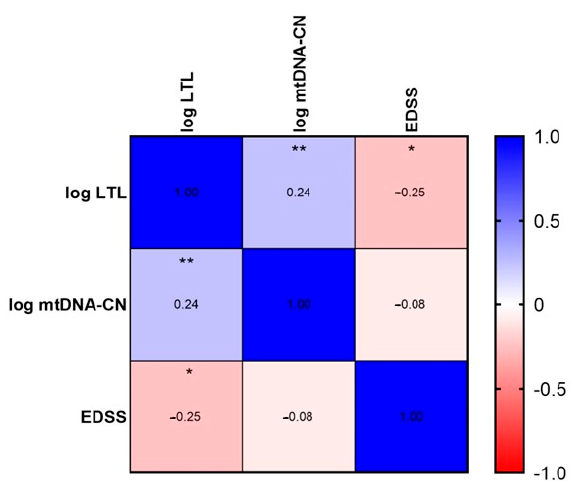
Figure 4. Spearman correlation test was performed with a * p = 0.034 for LTL and EDSS and a ** p = 0.038 for LTL and mtDNA-CN.